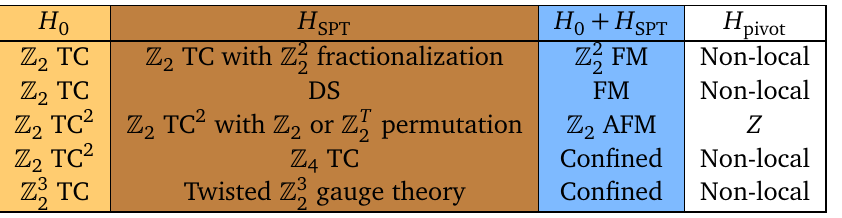
Table 2: Summary of various direct transitions between topological phases obtained by gauging the DQCP transition between trivial and (cid:90) 3 table, the multicritical point is found at 1 color coding of the table is for ease of comparison to the phase diagram in Fig.